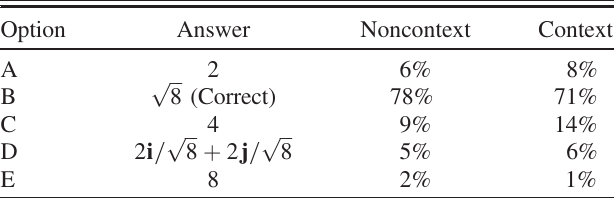
TABLE VII. Results of item 11: Students have to calculate the magnitude of the vector or force 2 i þ 2 j .